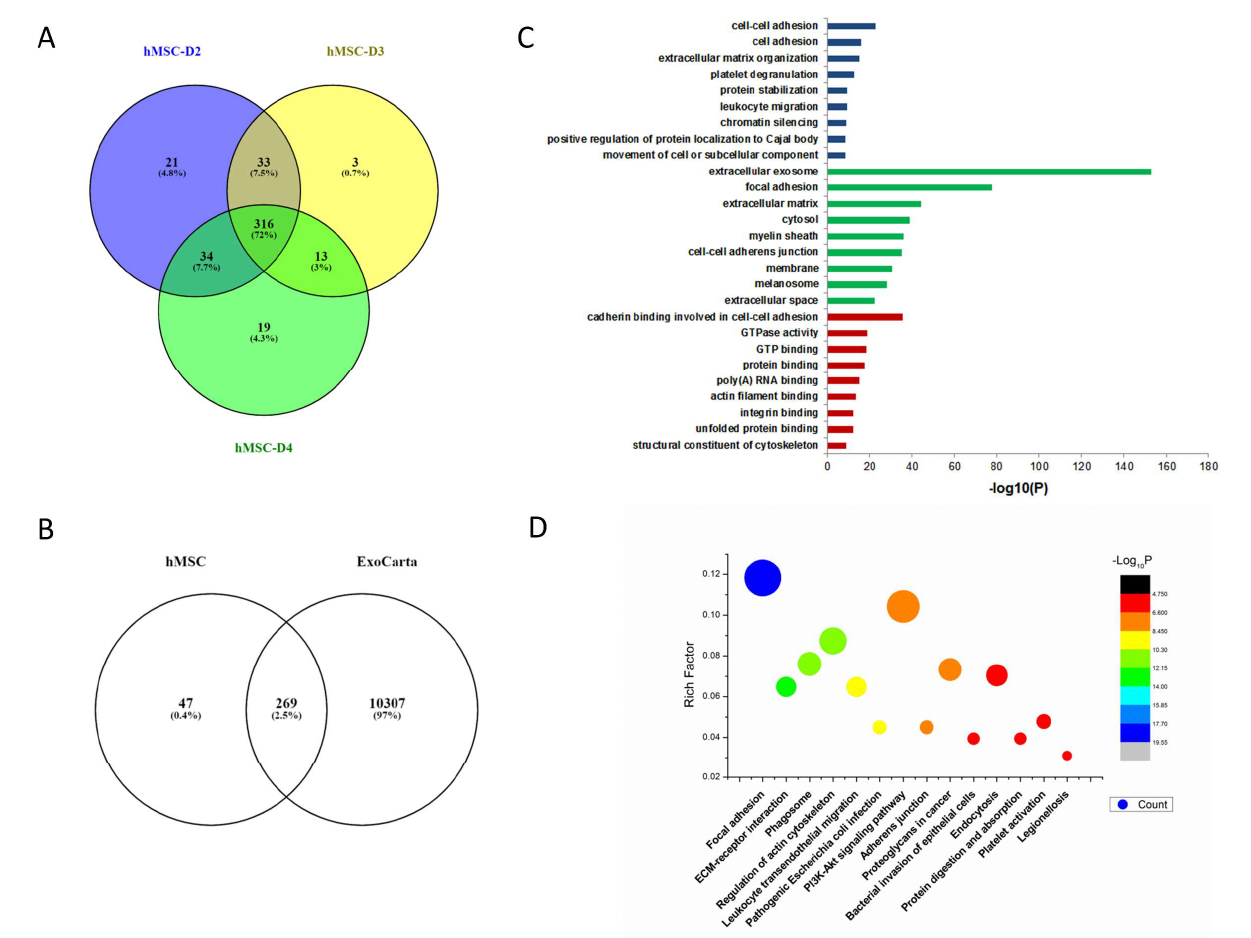
Figure 2. Bioinformatic analysis of hMSC exosomes. ( A ) Venn diagram of exosomes derived from hMSCs from bone marrow of three different donors. ( B ) Venn diagram of hMSC-derived exosomes against ExoCarta, an exosome database. ( C ) Gene Ontology analysis of hMSC exosomes. ( D ) KEGG analysis of hMSC exosomes.